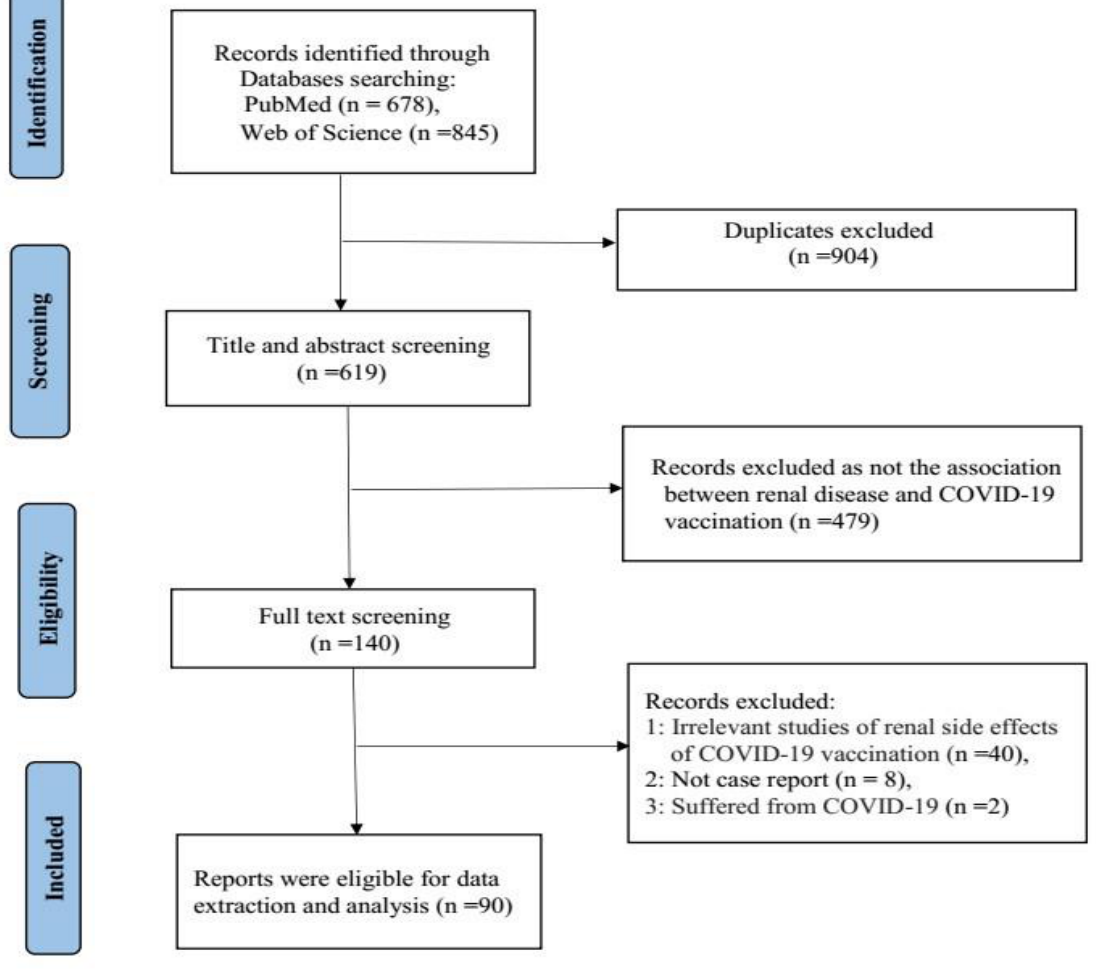
Figure 1. PRISMA flow diagram.